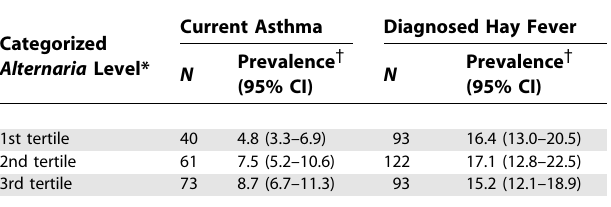
Table. Prevalence of Current Asthma and Diagnosed Hay Fever by Average Alternaria alternata Antigen Level in the Household Categorized Alternaria Level*